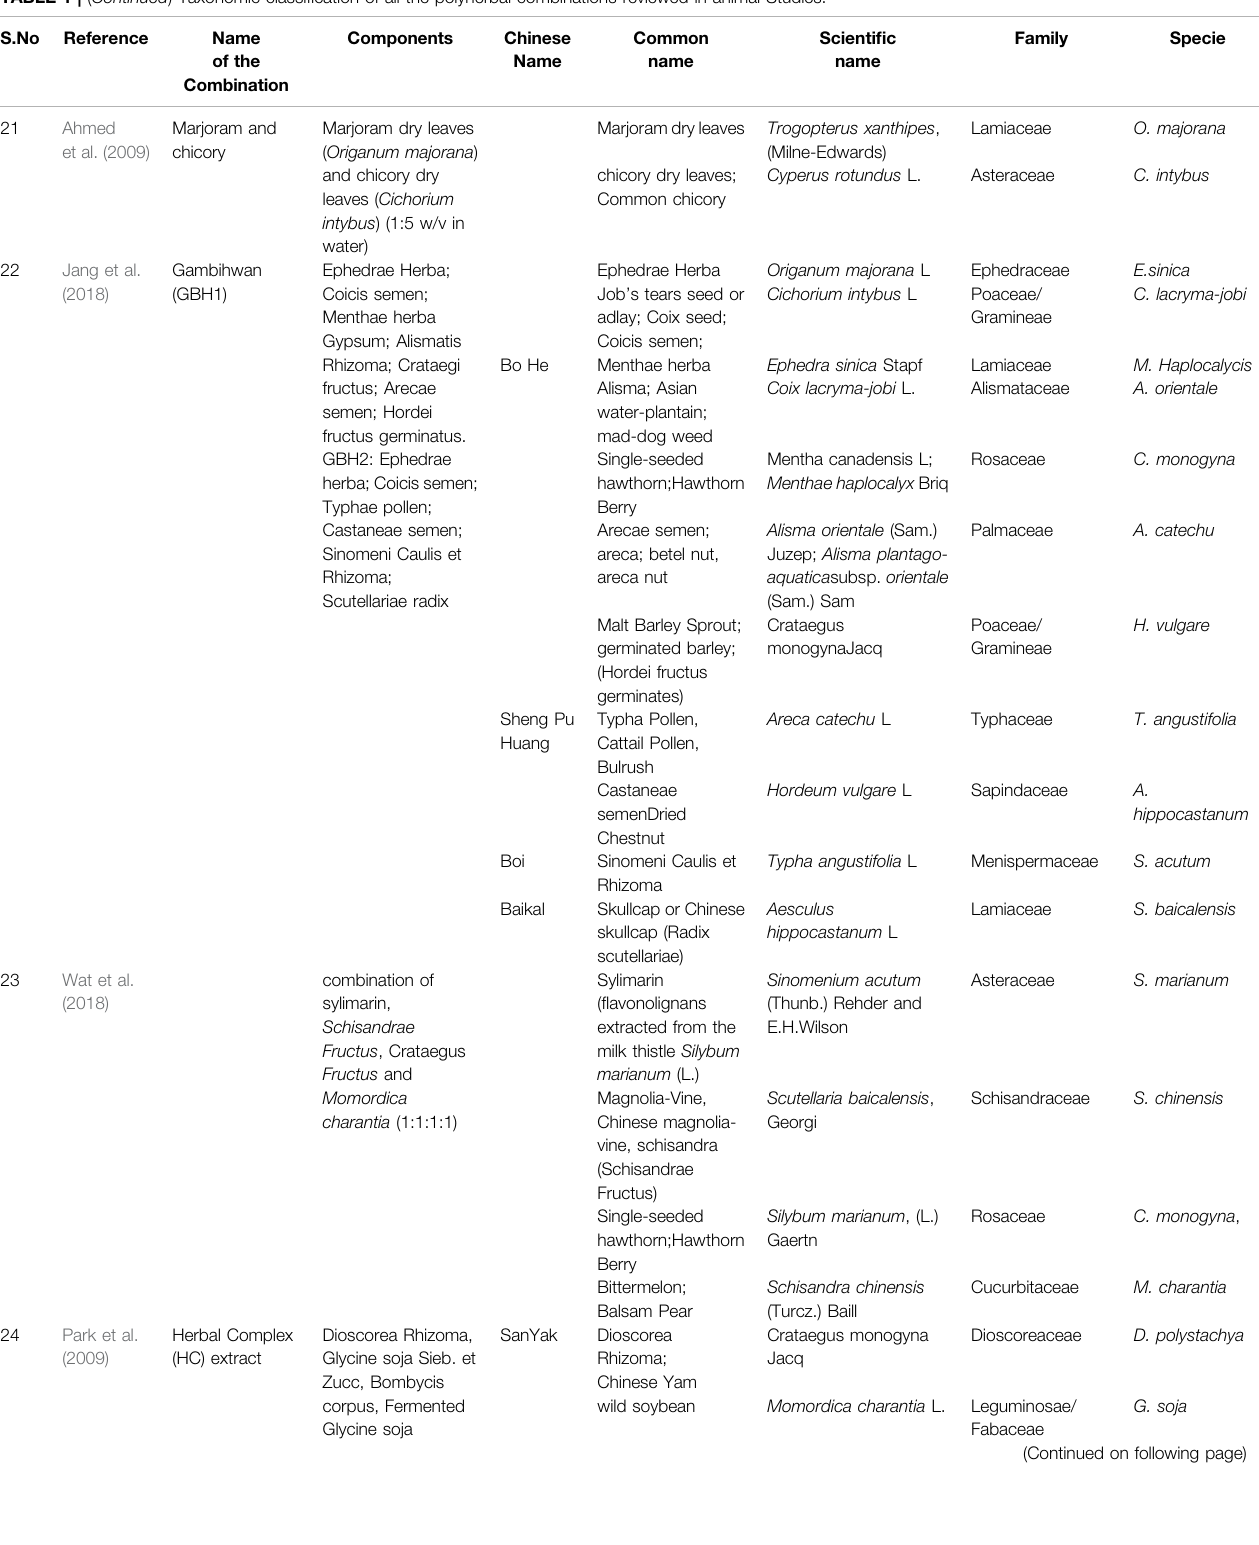
TABLE 1 | ( Continued ) Taxonomic classi fi cation of all the polyherbal combinations reviewed in animal